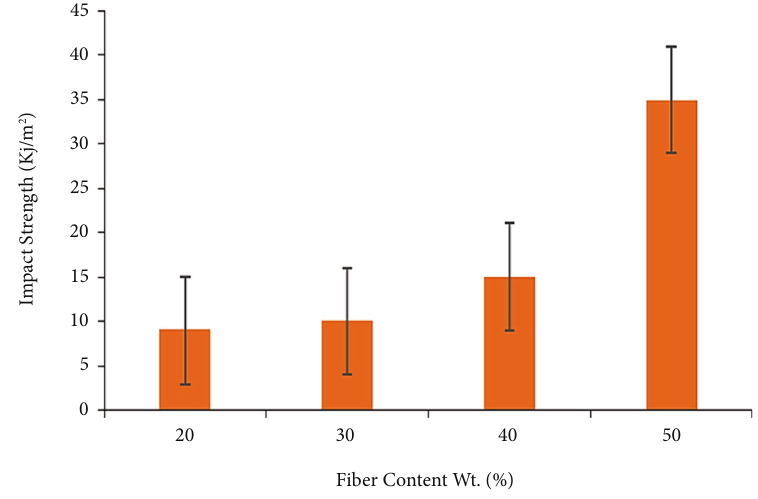
Figure 8: Impact strength vs. fi ber